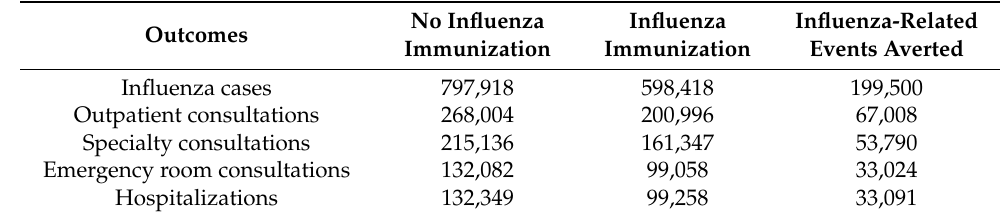
Table 6. Estimated influenza-related events averted by immunizing the target population 1